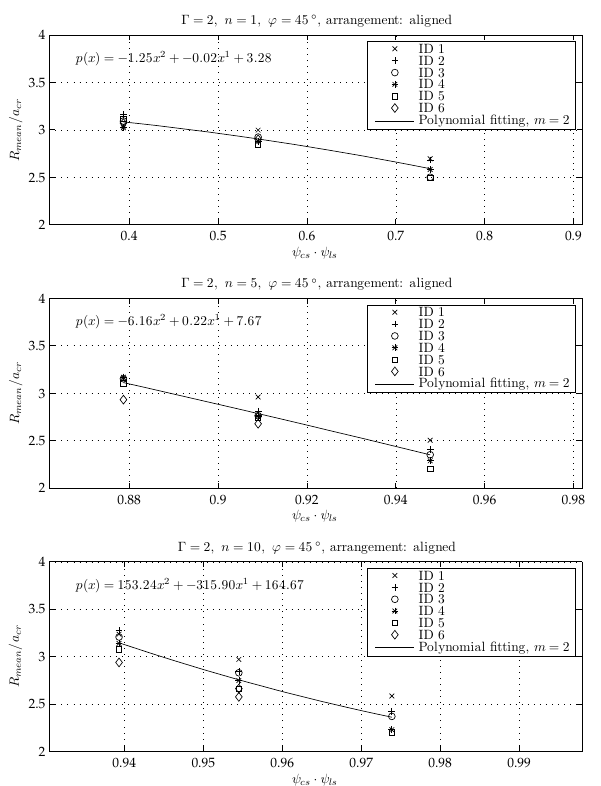
Fig. 12. The relative wave run-up ( R mean ) as a function of the cross- shore obstruction ratio ( ψ cs ) times the long-shore obstruction ratio ( ψ ls ), 0 = 2. The experimental data are fitted to a polynomial of de- gree m = 2 and the equations are given according to the investigated number of macro-roughness rows n = 1 , 5 ,